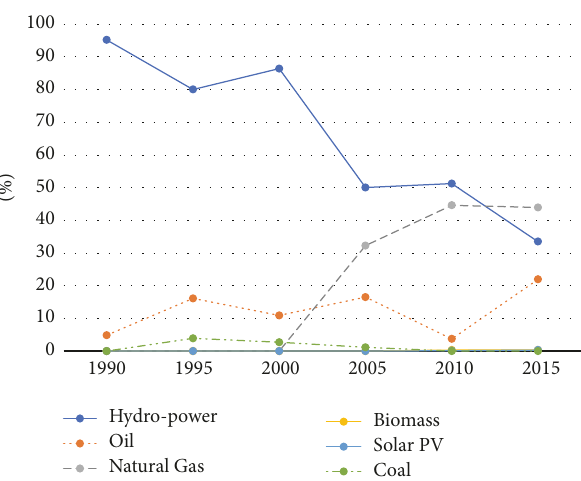
Figure 6: The role of hydropower within electricity generation 1990–2015 [12].